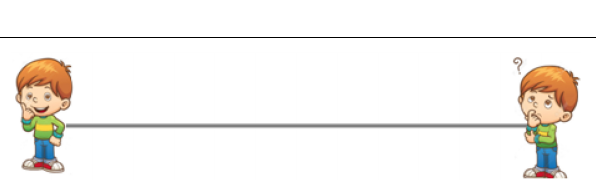
each test. The correlation of MFT and CMTT was significant with r =